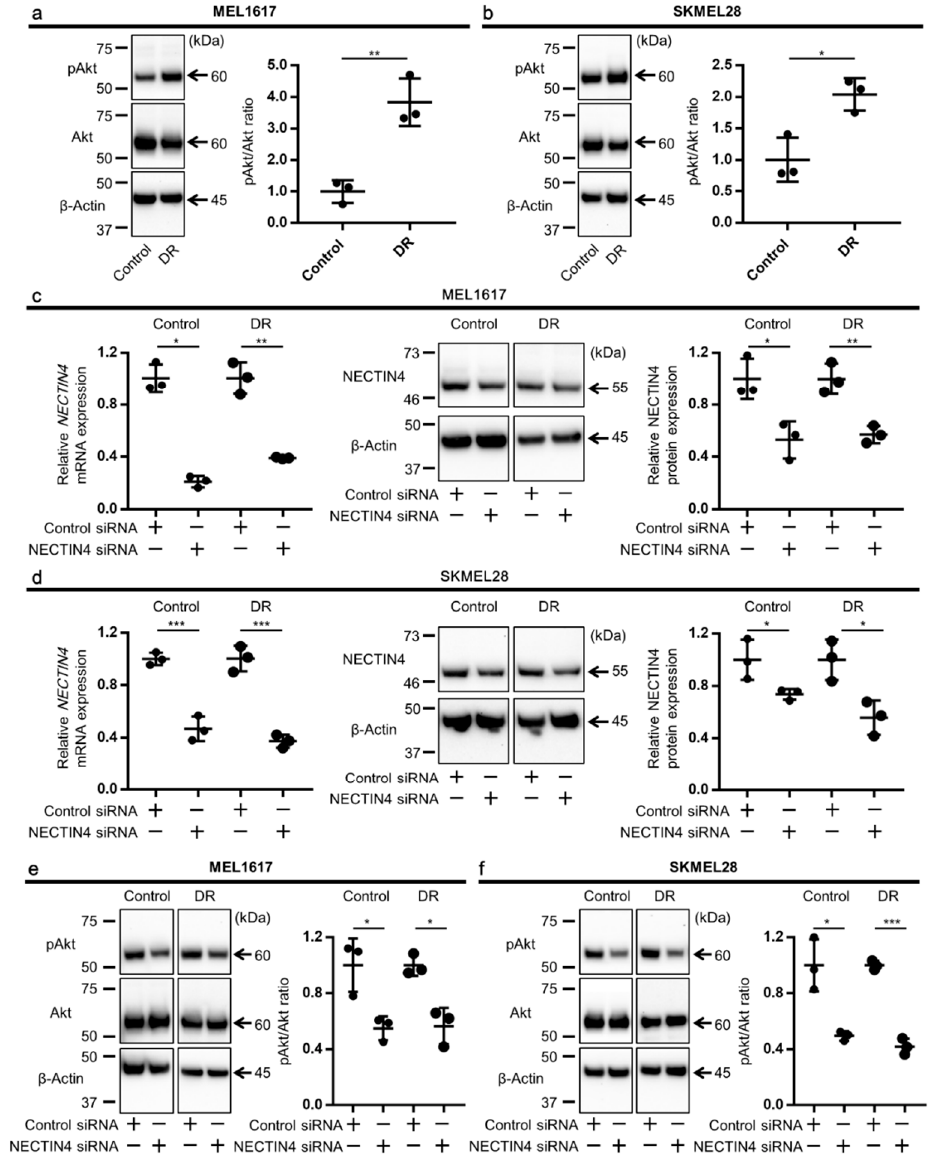
Figure 3. Phosphorylation of Akt is upregulated in BRAFi-resistant melanoma cells which are inhibited by NECTIN4 silencing. The pAkt/Akt ratio was determined by Western blotting. Representative gel images and relative pAkt/Akt ratios in ( a ) MEL1617 and ( b ) SKMEL28, and their DR cell lines are shown ( n = 3). Cells were transfected with control or NECTIN4 siRNA for 48 h. Knockdown efficiency of NECTIN4 at mRNA (left panels) and at protein (middle and right panels) in ( c ) MEL1617 and ( d ) SKMEL28, and their DR cell lines are shown. pAkt/Akt ratio in ( e ) MEL1617 and ( f ) SKMEL28, and their DR cell lines transfected with NECTIN4 siRNA for 48 h. Representative gel images and the pAkt/Akt ratio relative to that of control siRNA-treated samples are shown ( n = 3). Data are presented as the mean ± standard deviation of three independent experiments. β -Actin served as a loading control. * p < 0.05, ** p < 0.01, and *** p < 0.001 determined by Student’s unpaired two-tailed t -test.